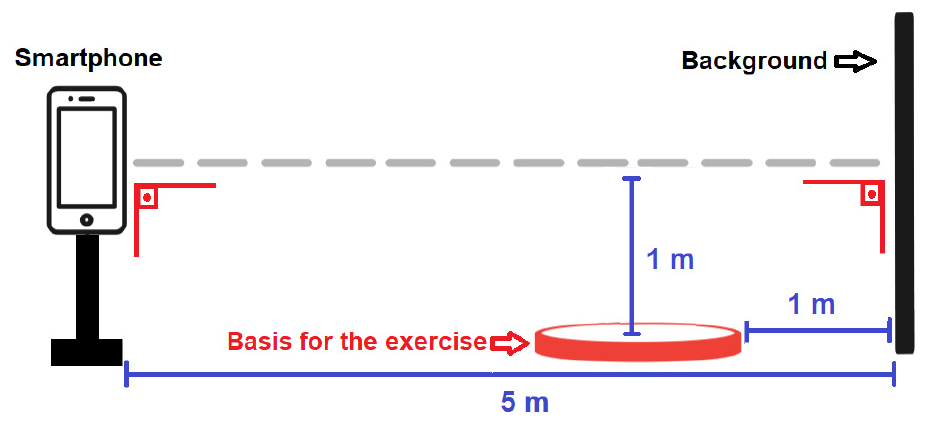
Figure 2. Schematic representation of the video capture setup.